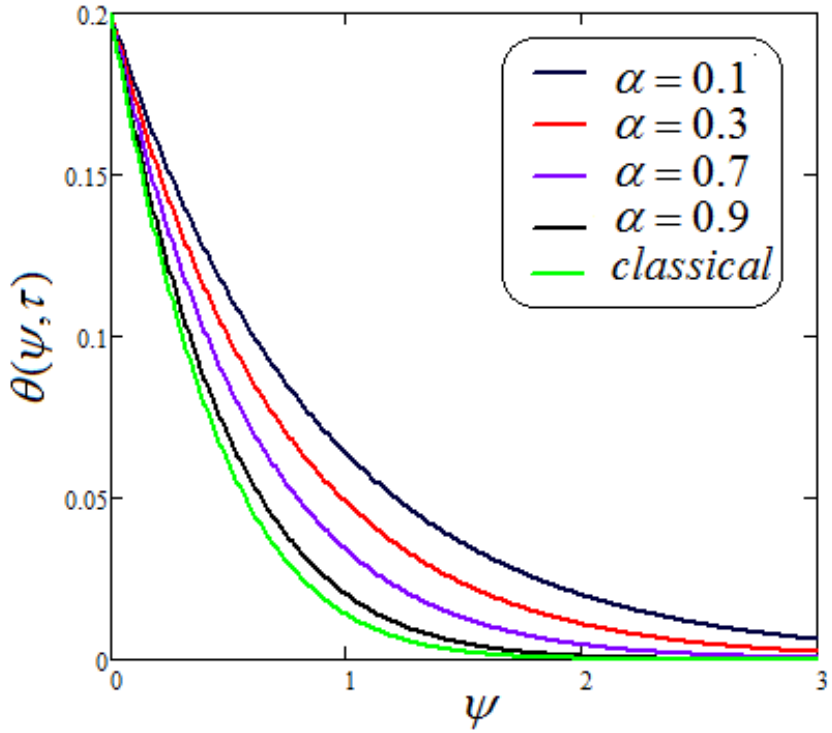
Figure 16. Trace of temperature for dissimilar values of α